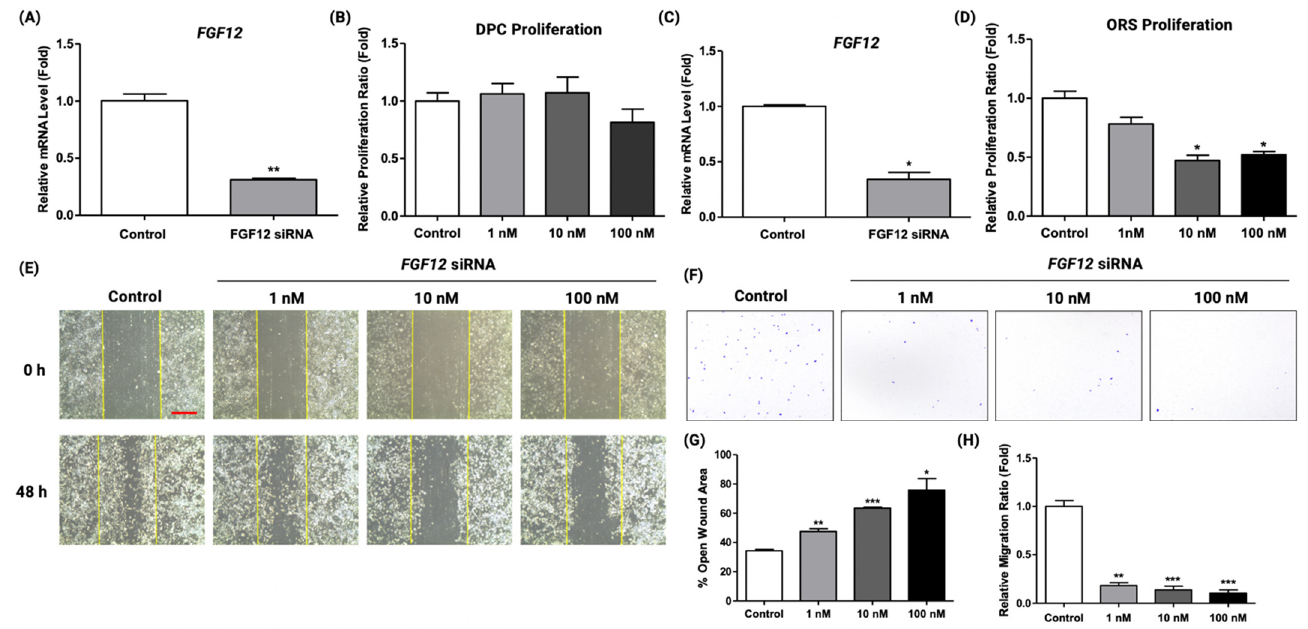
Figure 3. siRNA-mediated knockdown of FGF12 inhibited the proliferation and migration of ORS cells. ( A ) qRT-PCR result confirmed the siRNA-mediated knockdown at mRNA level in dermal papilla (DP) cells; n = 3. ( B ) The proliferation property of DP cells was examined with FGF12 siRNA treatment in a dose-dependent manner; n = 3. ( C ) qRT-PCR result confirmed the siRNA-mediated knockdown of FGF12 at mRNA level in outer root sheath (ORS) cells; n = 3. ( D ) The proliferation property of ORS cells was examined with FGF12 siRNA treatment in a dose-dependent manner; n = 3. FGF12 knockdown decreased the proliferation rate of ORS cells at the concentration of 10 nM and 100 nM. ( E ) FGF12 knockdown inhibited the migration of ORS cells in a wound scratch assay. The images at 0 h were taken immediately after the scratch was made. After 48 h, the migration of ORS cells was recorded. scale bar = 50 μ m. ( F ) Representative images of transwell migration assay upon treatment of FGF12 siRNA are shown. siRNA-mediated FGF12 knockdown significantly suppressed the migration of ORS cells. ( G ) Wound scratch assay results were quantified and represented as percentages of open wound area; n = 3. ( H ) Quantification of transwell migration assay indicated that ORS cell migration was inhibited by siRNA-mediated FGF12 knockdown; n = 3. All data expressed as mean ± standard error (* p < 0.05, ** p < 0.01, *** p < 0.001 versus the control group).